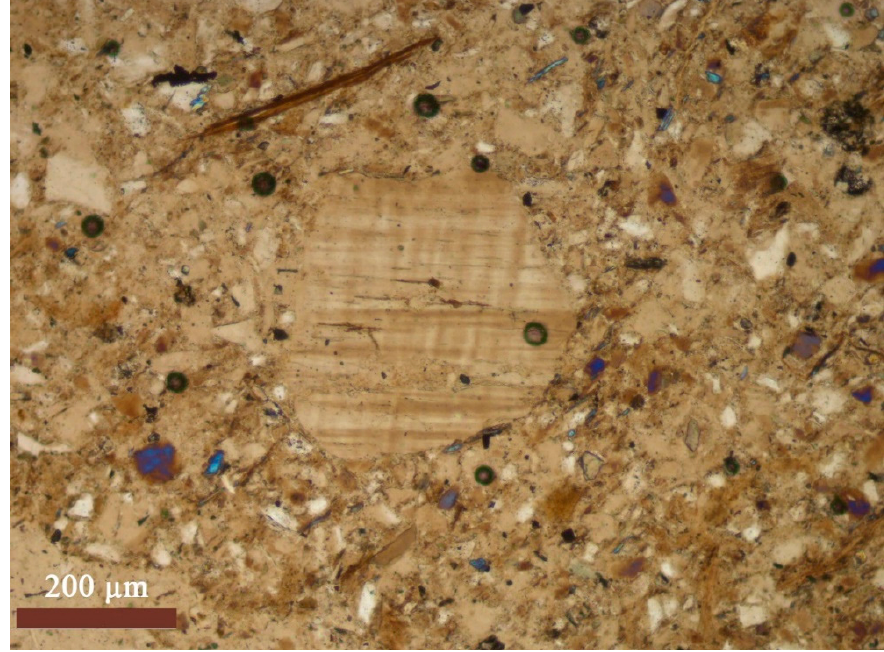
Figure 14. Contact void due to cryogenic processes in the soils. Feldspar mineral. S 3 (16–25 cm). Plane polarized light.